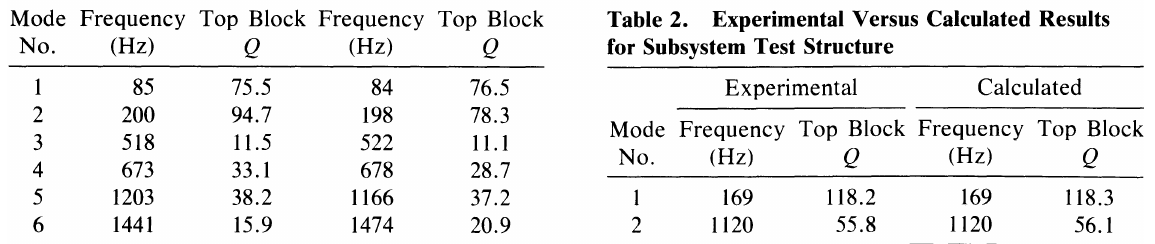
Table 1. Experimental Versus Calculated Results for Combined Test Structure Experimental Calculated Mode Frequency Top Block Frequency Top Block Table 2. Experimental Versus Calculated Results